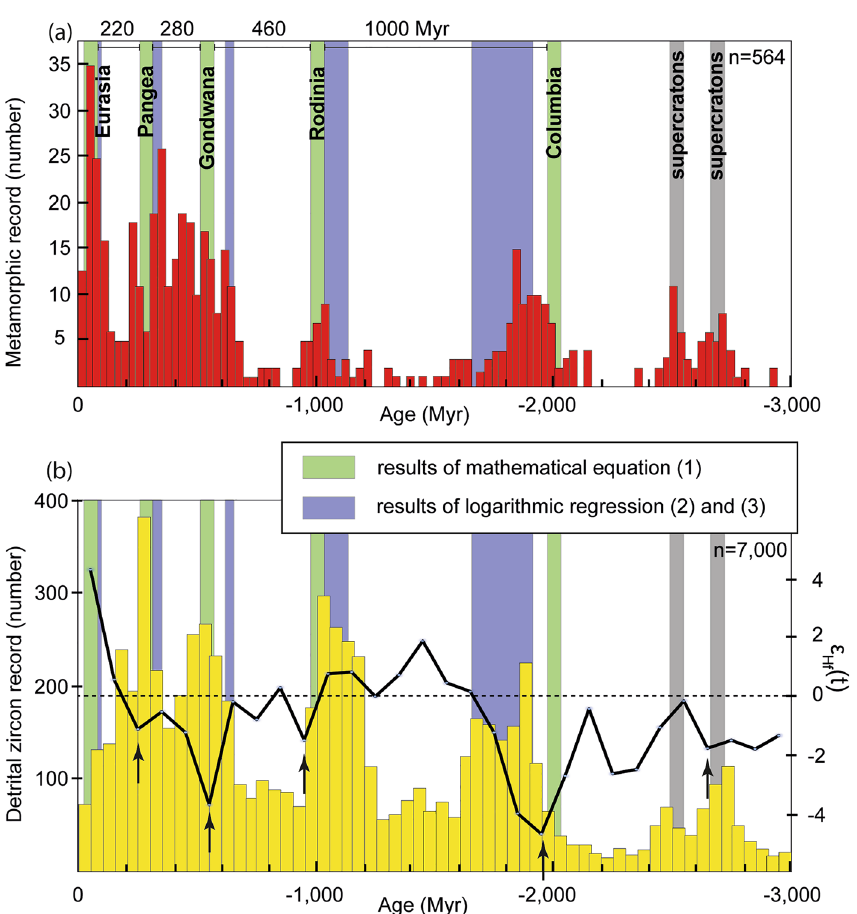
Figure 3. a Probability density plot for the Earth’s metamorphic record adapted from Brown, et al. 19 (database in Brown and Johnson 18 ). b Probability density plot for the detrital zircon record adapted from Campbell and Allen 17 superposed with the ε Hf (t) record taken from Puetz and Condie 29 . The ε Hf (t) record (black curve, with right hand side axis) is plotted as the mean value for each 100 Myr bin. The different inferred assemblies obtained in this study are portrayed in a and b and show relatively good matches with the three geological